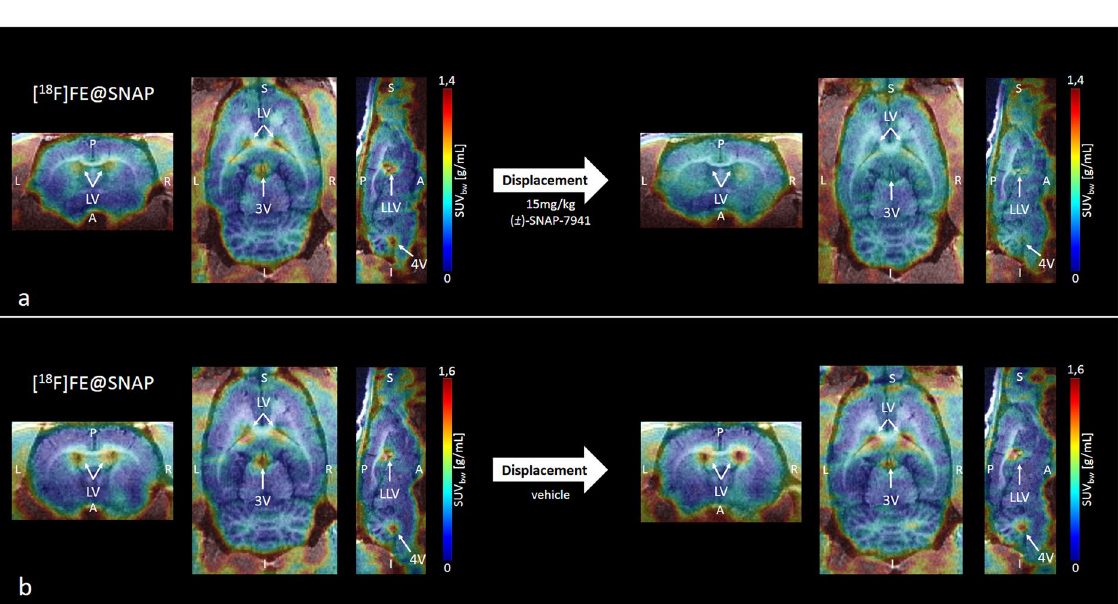
Figure 4. Small-animal PET/MR brain images of [ 18 F]FE@SNAP. Exemplary small-animal PET/MR images of representative coronal (left), horizontal (centre) and sagittal (right) planes of a rat brain with [ 18 F]FE@ SNAP before and after administration of 15 mg/kg ( ± )-SNAP-7941 ( a ) and with [ 18 F]FE@SNAP before and after administration of the corresponding vehicle ( b ). PET data are contributed to summation images from 0–20 minutes (before displacement) and from 20–60 minutes (after displacement). Anatomical structures are indicated by arrows ( LV = lateral ventricle; LLV = left lateral ventricle; 3V = third ventricle; 4V = fourth